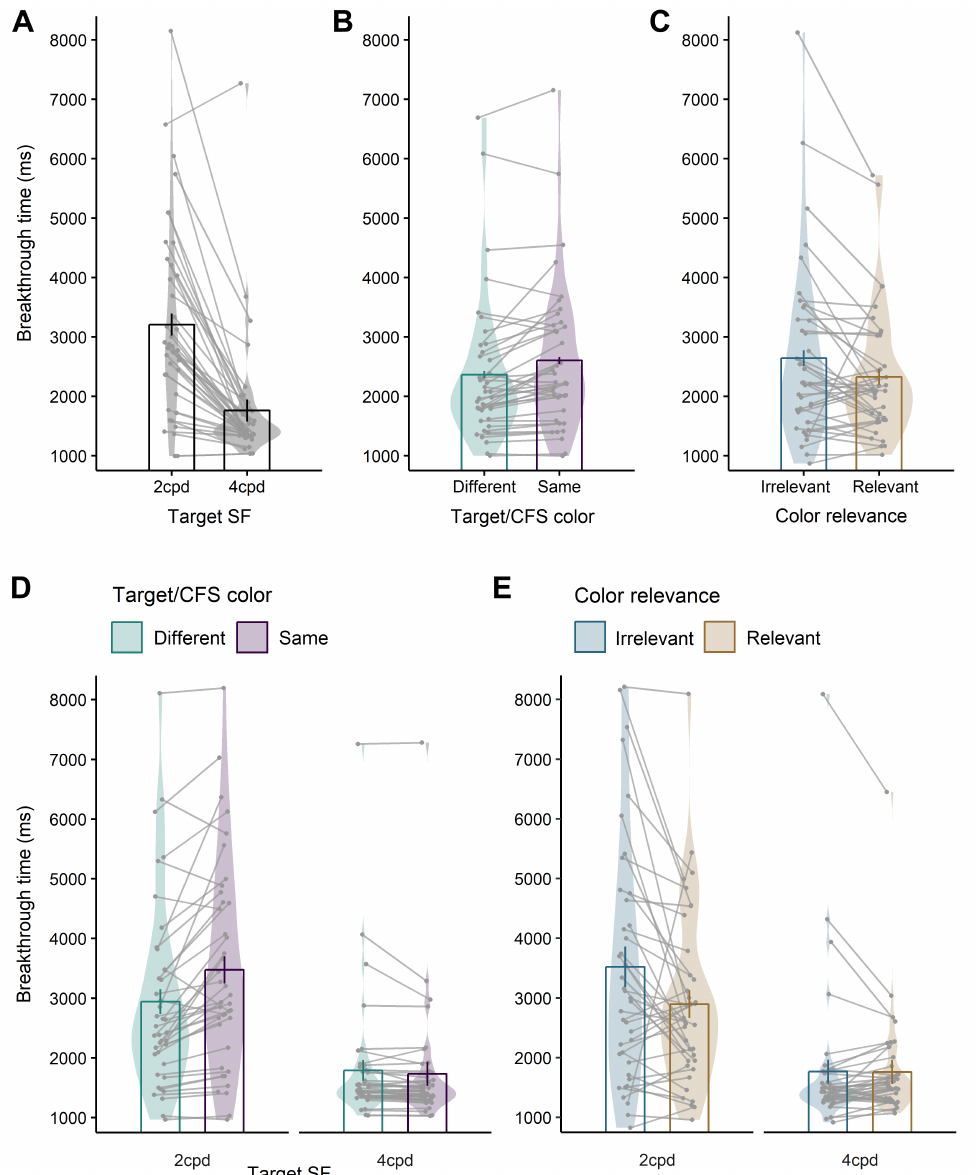
Figure 2. Significant results of the repeated measures ANOVA of breakthrough times in trials with cor- rect responses. The data points in each plot’s background represent the medians of the breakthrough time of individual participants, which were entered into the statistical model. Lines connect data points belonging to the same participants. The violin plots represent the distribution of data within each condition, and the bar graphs represent the condition means. Error bars represent ± 1.96 SE after correcting for between-participants variance [31]. ( A ) Main effect of target SF. ( B ) Main effect of target/CFS color. ( C ) Main effect of color relevance. ( D ) Interaction of Target SF × Target/CFS color. ( E ) Interaction of Target SF × Color